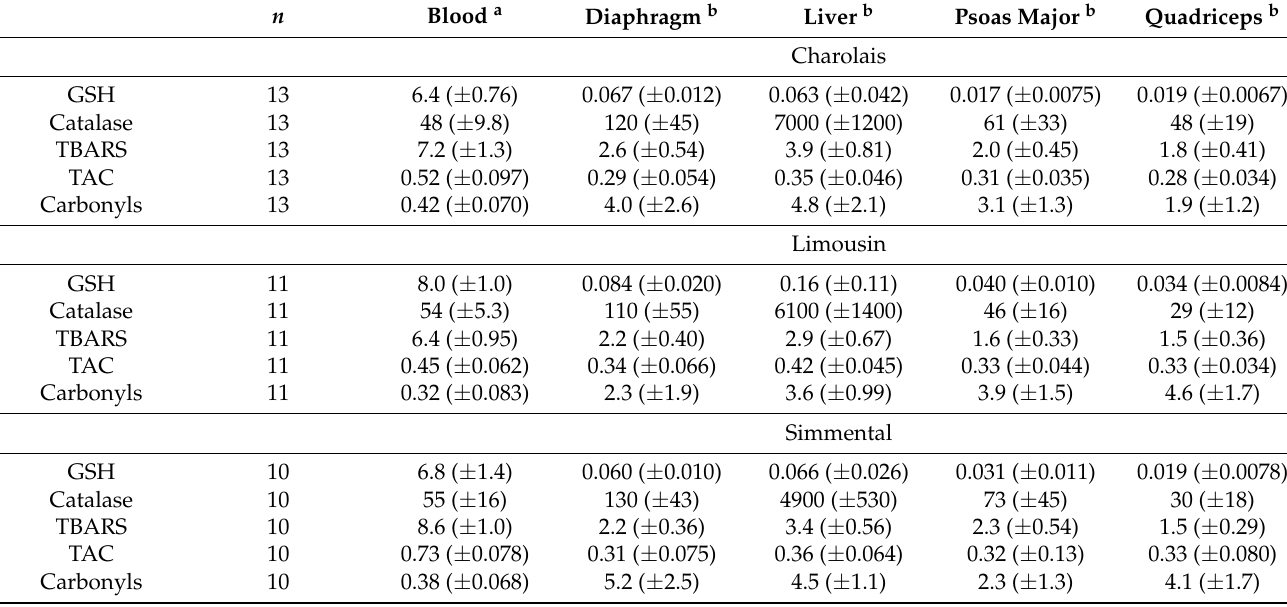
Table 1. Redox biomarker baseline levels in the cattle